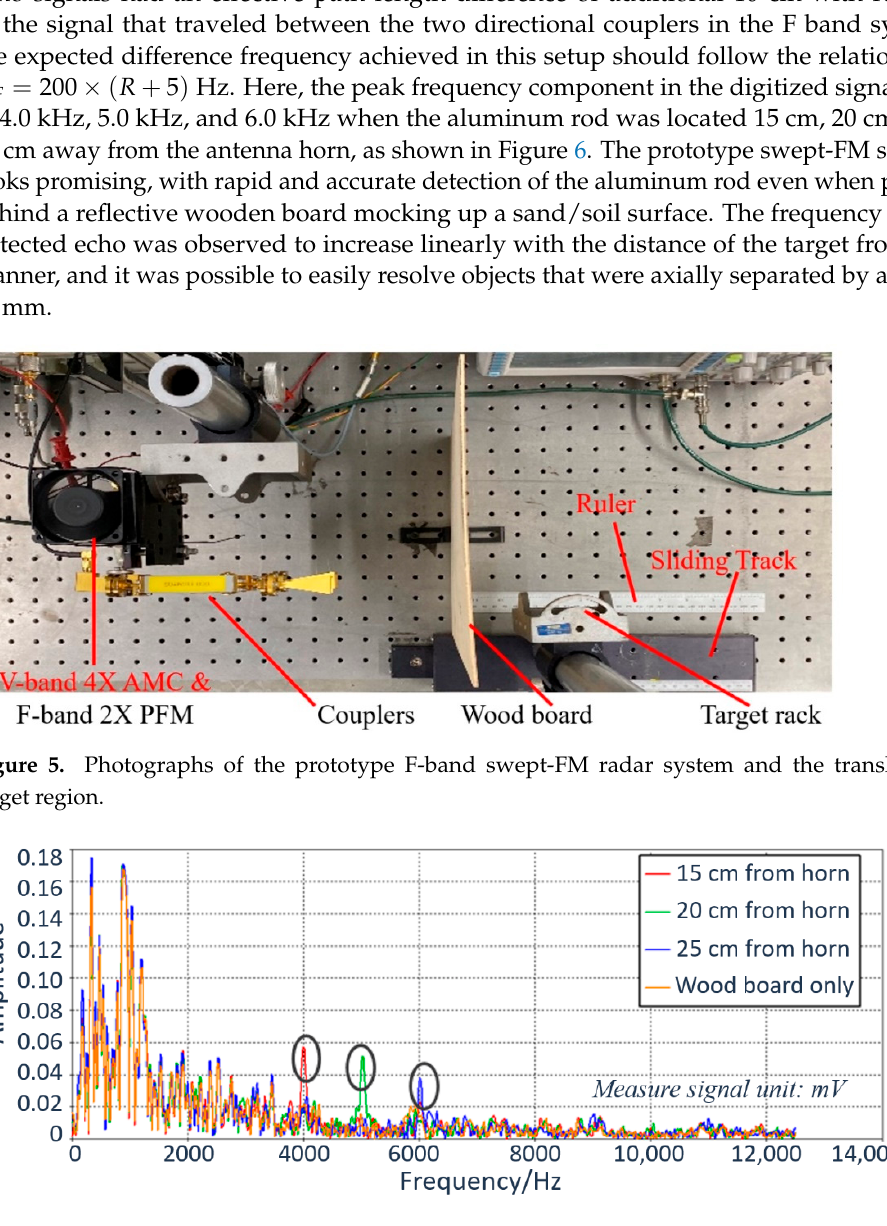
Figure 4. ( a ) Output and reference signals observed at a lens–target distance of 32 cm and ( b ) FFT of the output signal. A peak signal component of 4.7 kHz is observed . ( c ) Output and reference signals observed at a lens–target distance of 42 cm and ( d ) FFT of the output signal. A peak signal component of 5.9 kHz is observed.